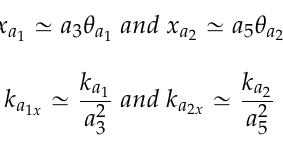
Figure 5. Equivalent linear model of the pendulum absorber.